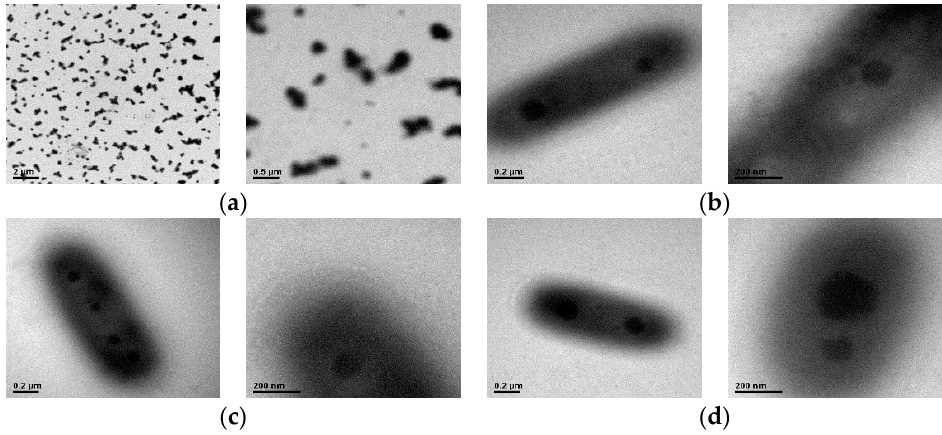
Figure 8. Transmission electron microscopic (TEM) images of: ( a ) CD-0; ( b ) CD-8; ( c ) CD-10; and ( d ) CD-12.